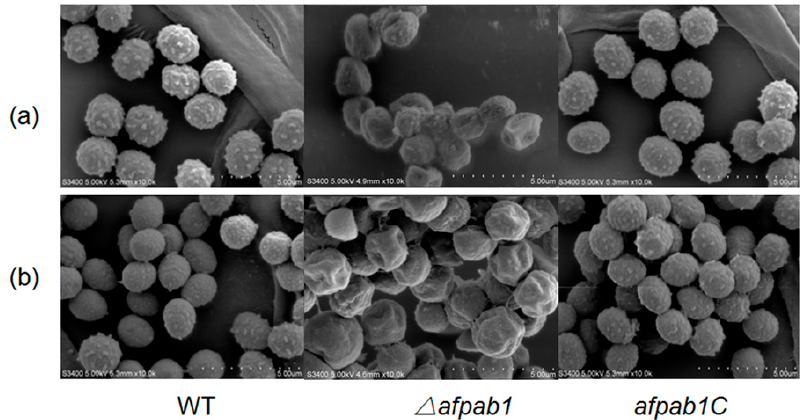
Figure 6. The coverslips covered on PDA cubes with spores were transferred and prefixed with 2% glutaraldehyde at room temperature for 12 h and then metalized with gold and investigated by scanning electron microscope. ( a ) Medium containing 1.5 mM H 2 O 2 ; ( b ) Medium containing 10 µM menadione.